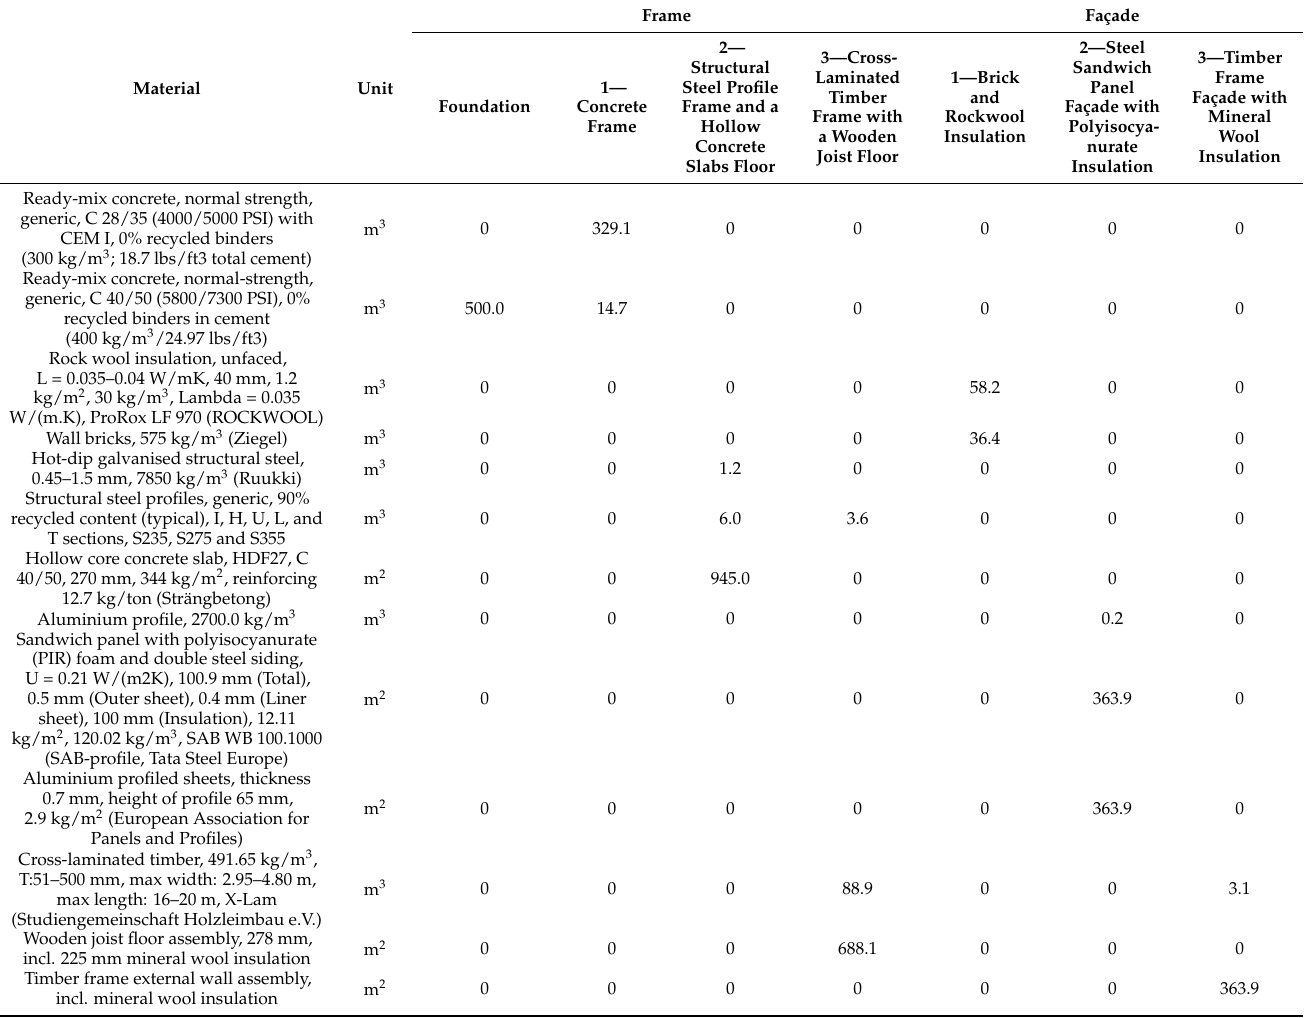
Table A1. Material composition of structural frame and façade